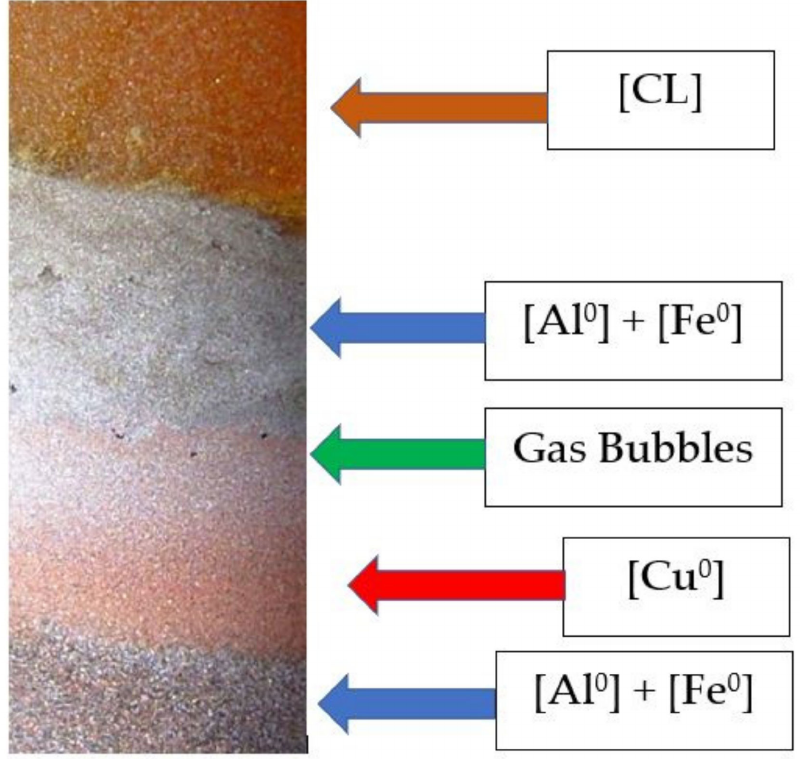
Figure 7. Example of a [CL]: ZVM interface showing gas bubbles encased in ZVM rising into the [CL] from the ZVM body. The ZVM body shows multiple layers of gravity separation with the heavy Cu 0 layers gradating upwards into a mixed Fe 0 :Al 0 layer. Gas bubbles develop within the ZVM Bed at the junction between the Cu 0 dominated zone and the Fe 0 :Al 0 dominated zone. Field of view width: 1 cm; retort casing changed, for this example, to glass (to allow